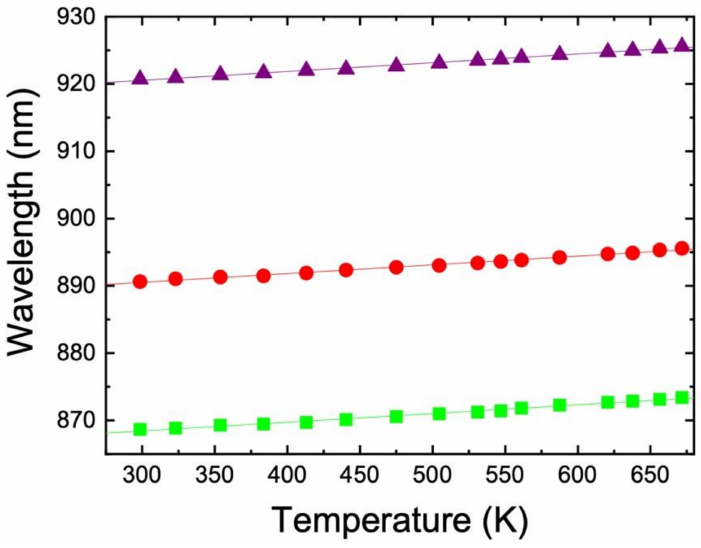
Figure 5. Displacement of three WGM peaks as a function of